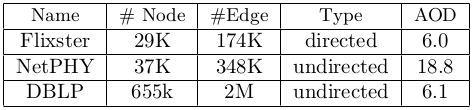
Table from the paper: Cumulative Activation in Social Networks
Table text:
Name
#Node
#Edge
Type
AOD
Flixster
29K
174K
directed
6.0
NetPHY
37K
348K
undirected
18.8
DBLP
655k
2M
undirected
6.1